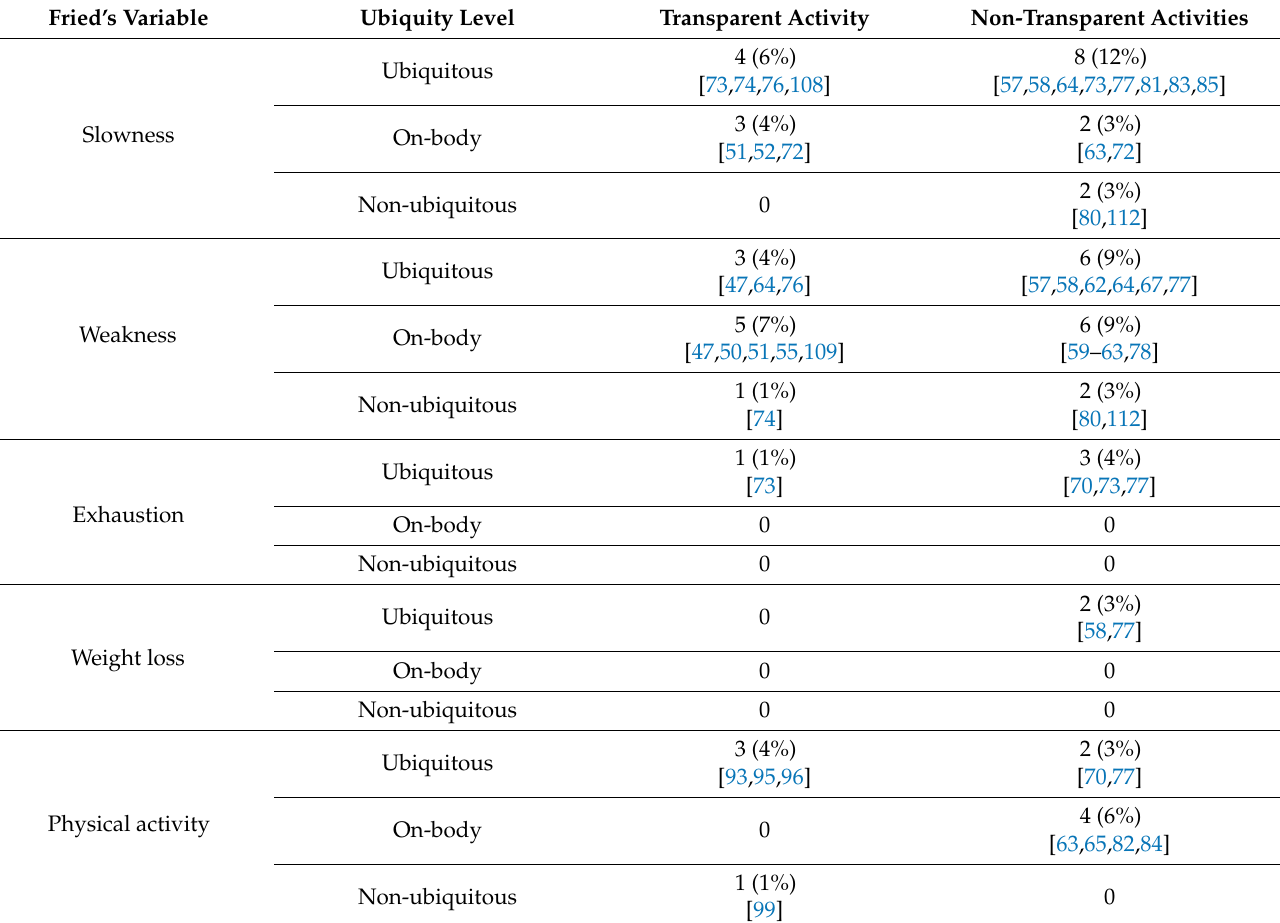
Table 5. Number of sensor-based studies assessing each of the Fried’s variables. The figures are displayed according to the sensors’ ubiquity and transparency levels. The figures in square brackets are the citations for the corresponding studies. The figures in brackets represent the percentage with respect to all 67 studies in the